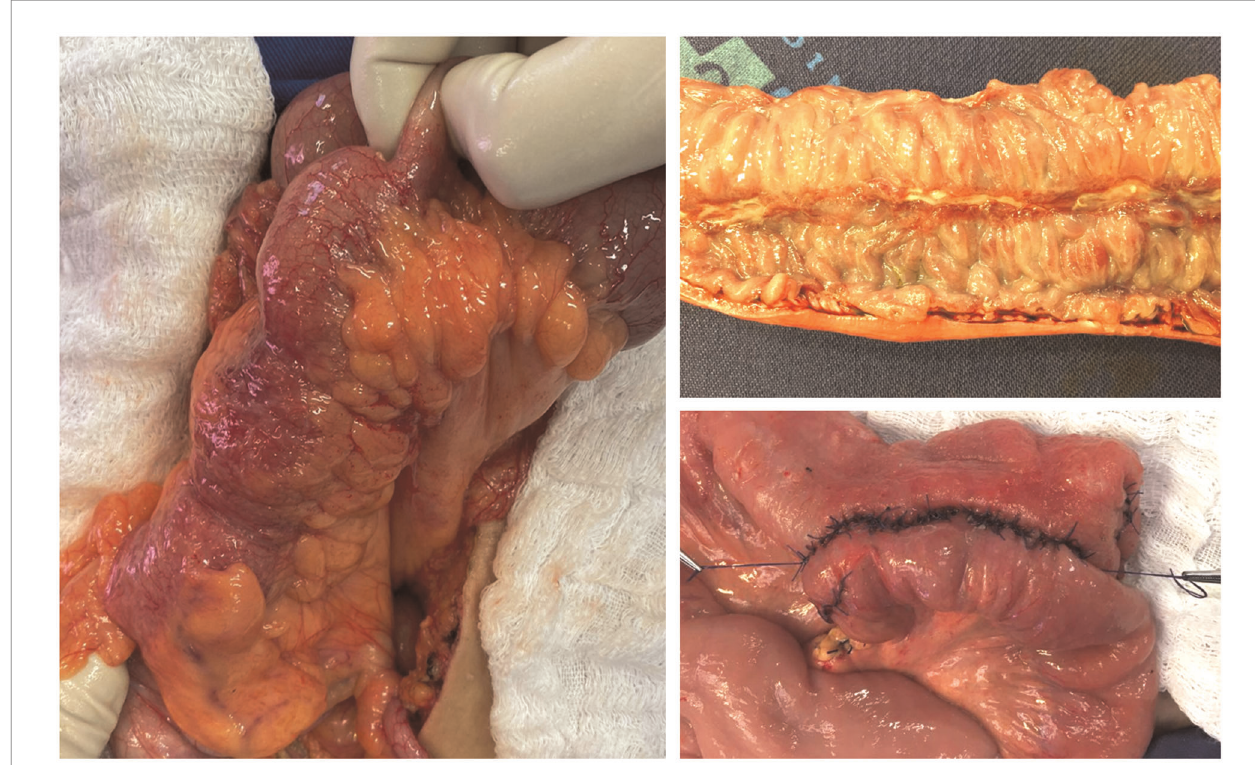
FIGURE 1 | Aspects of an anastomosis followed by an enterectomy for Crohn ’ s disease (CD). ( A ) Surgical aspect of the ileum affected by CD. ( B ) Surgical specimen showing a longitudinal deep ulcer in the in fl amed intestinal mucosa by the disease. ( C ) Side-to-side anastomosis. Source of the photographs: Colorectal Surgery Unit,